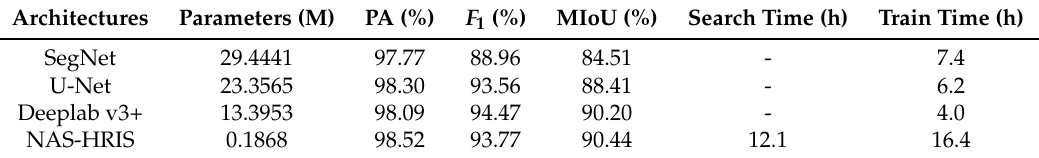
Figure 6. Examples of segmentation results with the SegNet, U-Net, Deeplab v3+ and NAS-HRIS, respectively, on the aerial dataset. ( a ) Image. ( b ) Label. ( c ) SegNet. ( d ) U-Net. ( e ) Deeplab v3+. ( f ) NAS-HRIS. Table 1. Testing result on